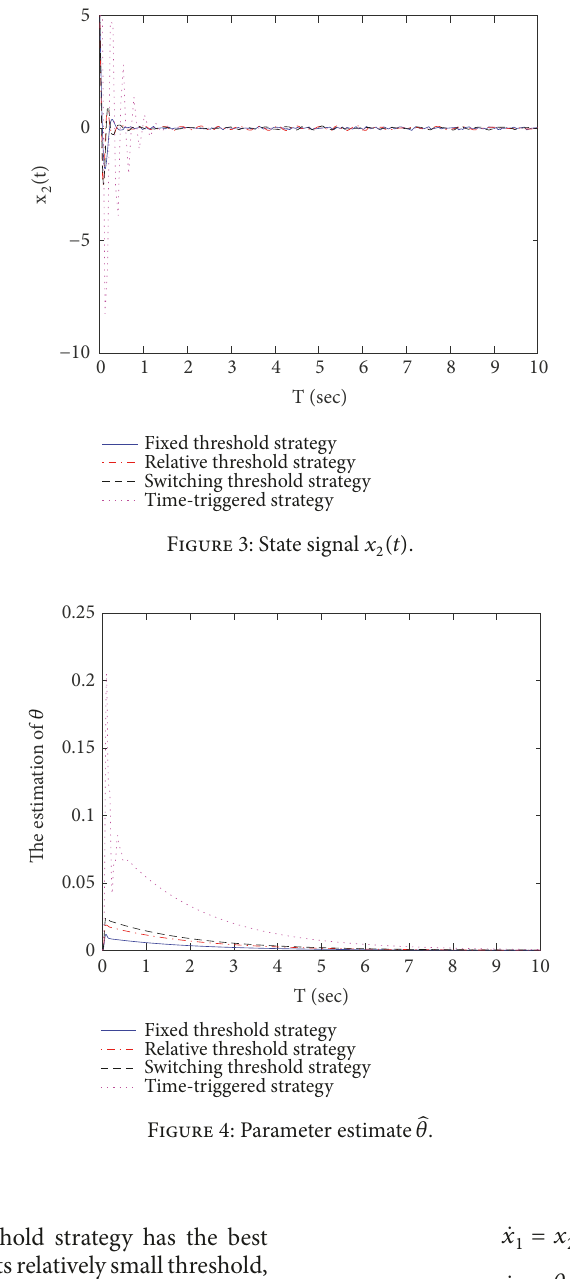
Figure 4: Parameter estimate